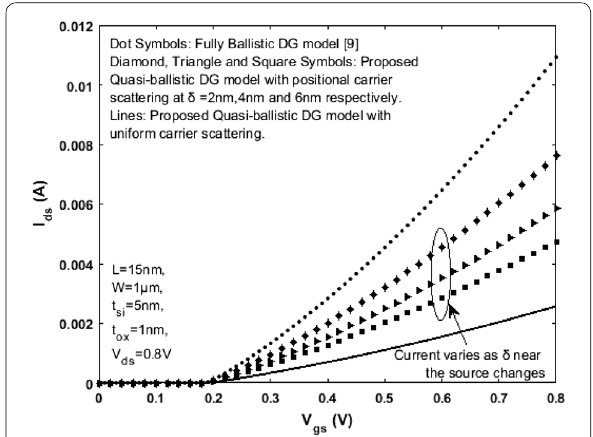
0.8 V = represented by different symbols. Q g ,Q d and Q s represent gate, drain and source charge respectively